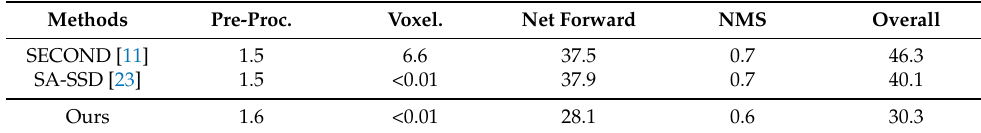
Table 12. Run time analysis (in milliseconds) of different steps during inference.